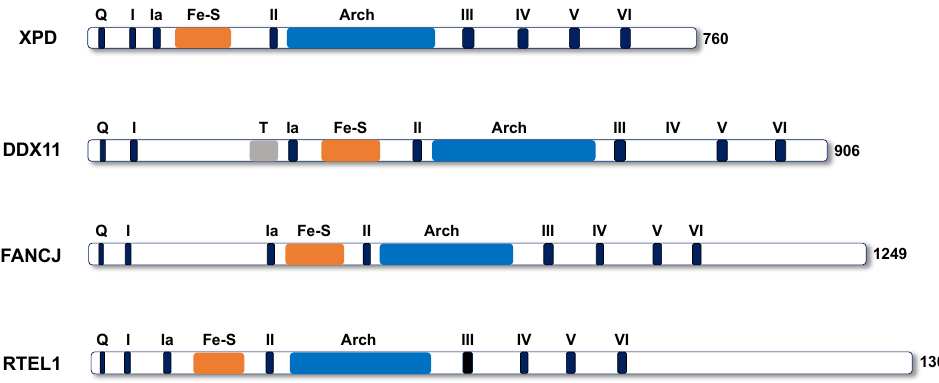
Figure 1. A schematic representation of the polypeptide chain of human super-family 2 DNA helicases containing an Fe–S cluster is reported. Color code is as follows: blue , conserved helicase motifs (Q motif, Q , and helicase boxes from I to VI); grey , Timeless-binding motif ( T ) [12]; orange , Fe–S cluster ( Fe–S ) and pale blue , Arch domain ( Arch ) domain.